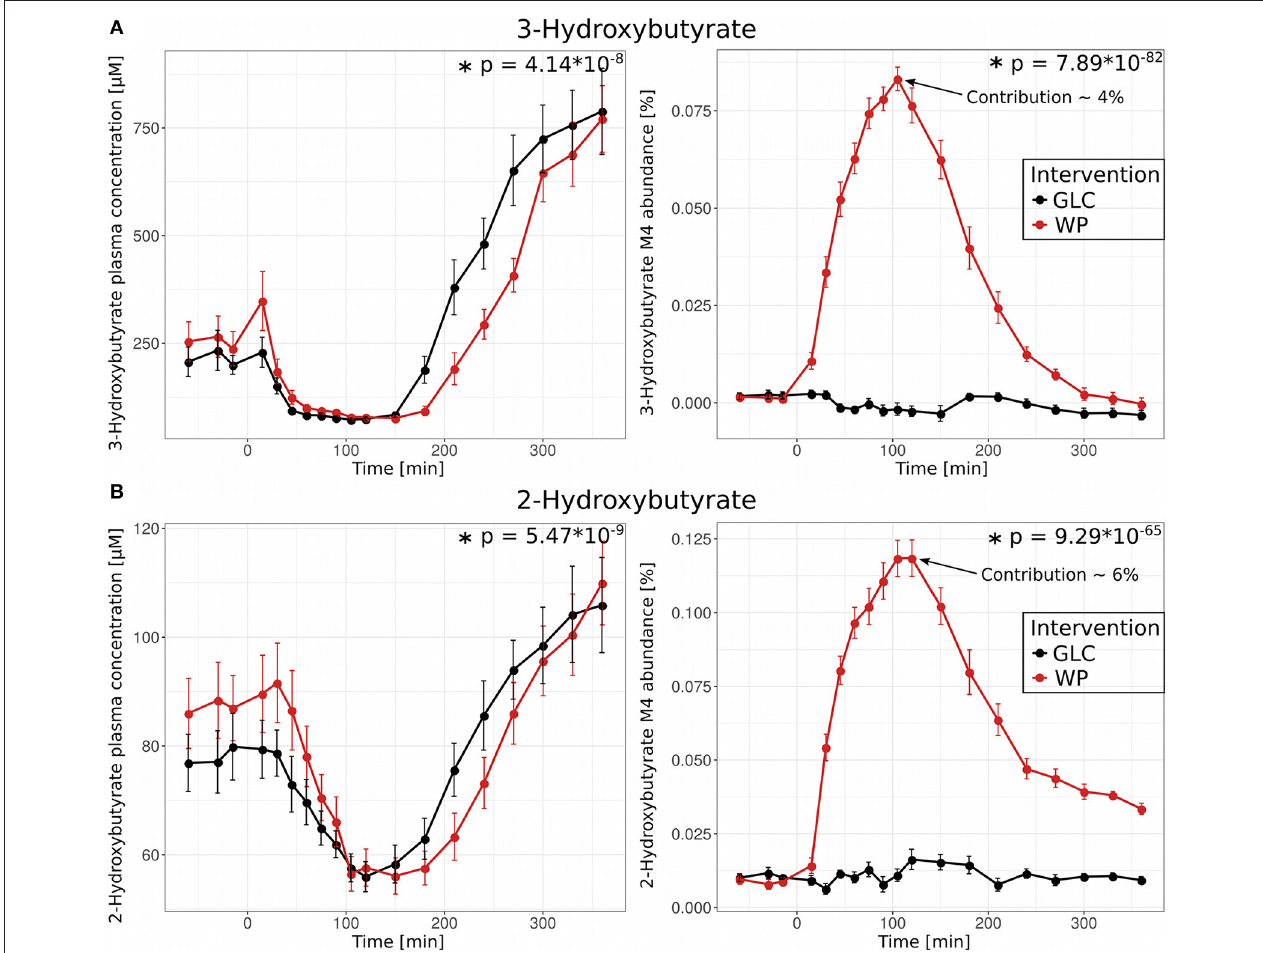
FIGURE 7 | Role of 3- and 2-Hydroxybutyrate in the postprandial phase. (A) 3-Hydroxybutyrate and (B) 2-Hydroxybutyrate plasma concentrations (left panel) and M4 isotopologue abundances (right panel) and resulting contribution to the total plasma pool 105min after glucose (GLC, black) and wheat porridge (WP, red) intake; displayed is the average of eleven subjects ± standard error of the mean (SEM), statistics: